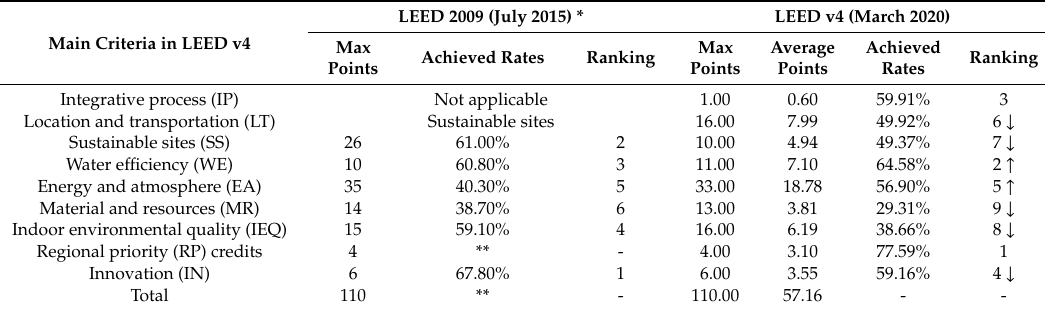
Table 5. Comparison of the distribution trends for the main criteria in LEED 2009 and LEED v4. Main Criteria in LEED